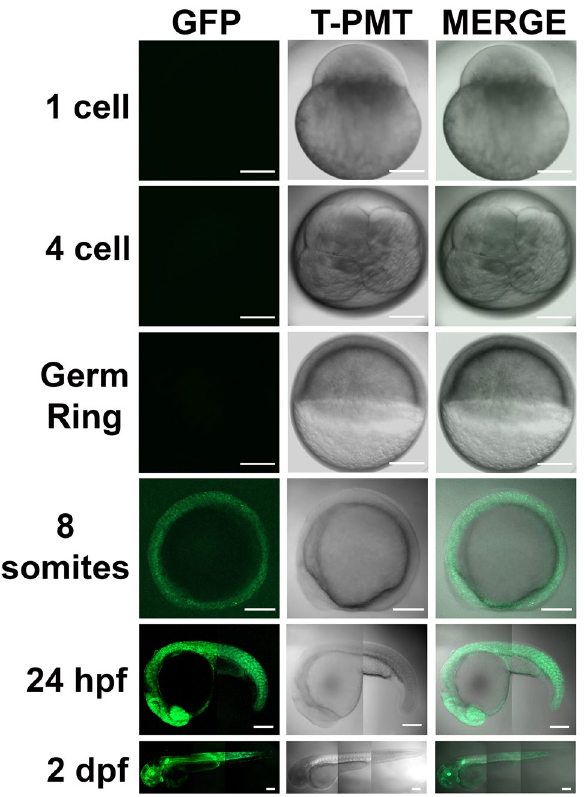
Figure 4. Expression of Adamts9 in F2 transgenic ( Tg(adamts9:GFP) ) embryos during embryonic development. The expression of Adamts9 was determined by EGFP expression driven by adamts9 promoters located in a 4.5 kb upstream sequence of adamts9 start codon. Representative confocal z-stack images of various stages of development embryos were imaged by a confocal microscope under EGFP or transmit light (T-PMT) channels. Similar expression was confirmed in multiple F2 embryos from five independent F1 transgenic lines ( Tg(adamts9:GFP) ). Scale bar: 200